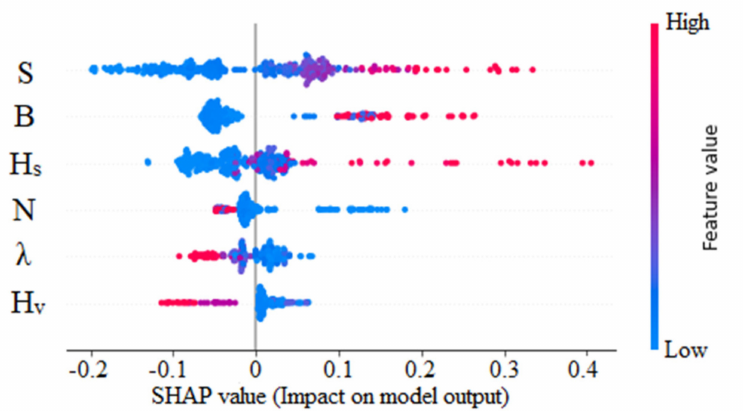
Figure 12. Absolute mean SHAP values of XGBoost model (U B prediction).